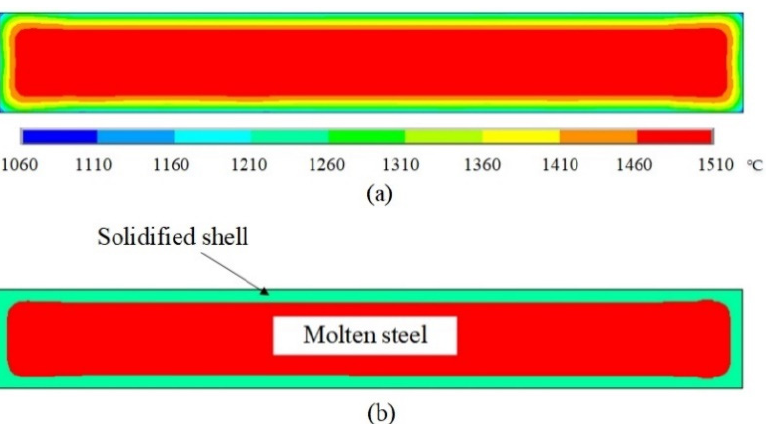
Figure 6. Temperature distribution and solidified shell. ( a ) temperature distribution; ( b ) solidified shell.